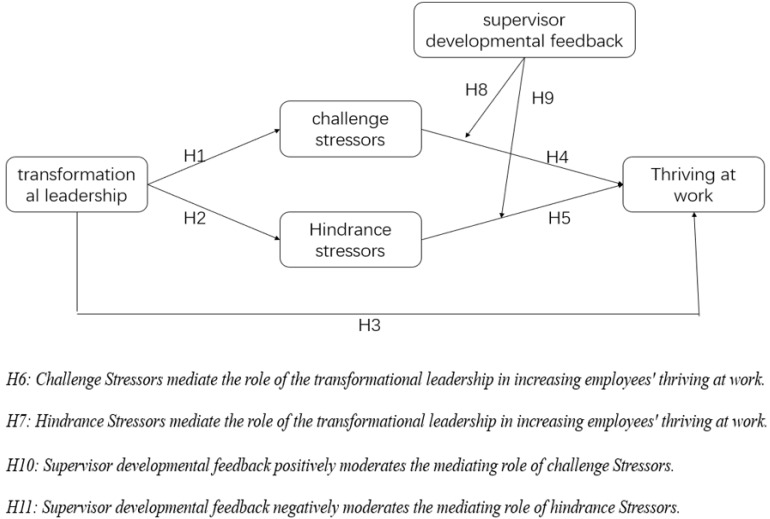
Hypotheses Model.